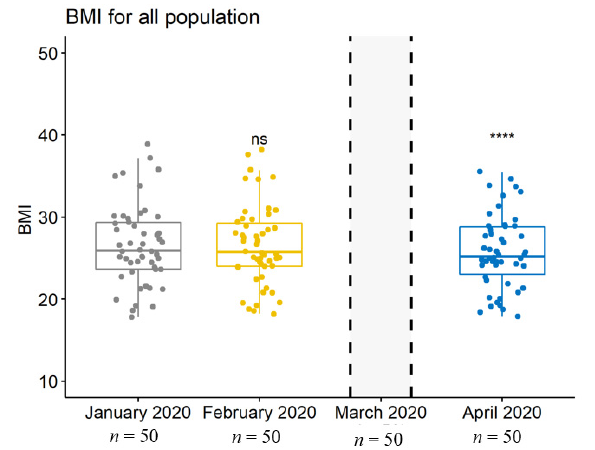
Figure 2. Boxplot depicting the population’s body mass index (BMI) at each data collection. ns,